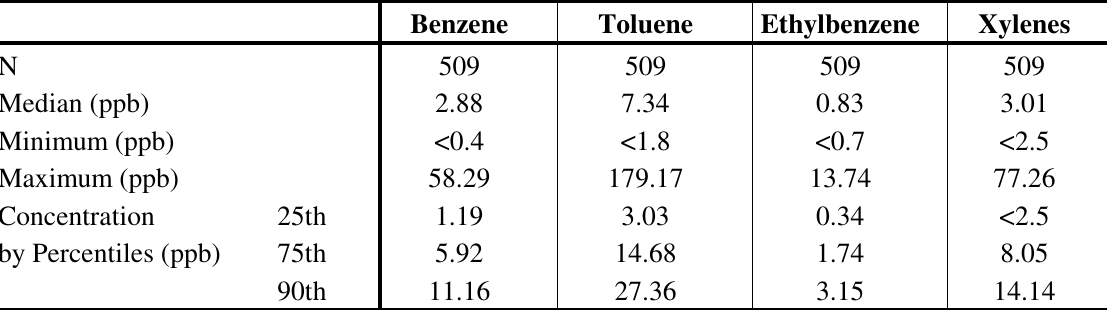
Table 2. Descriptive statistics for indoor air BTEX analysis.